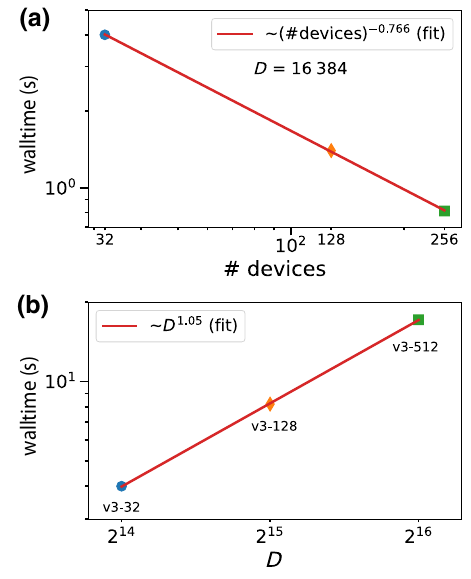
FIG. 5. (a) Strong scaling analysis for a DMRG-style matrix- vector operation for a bond dimension of D = 16384 on an increasingly larger number of TPU cores. Doubling the number of devices we observe a roughly (2 0.766 ≈ 1.7)-fold reduction in runtime. For ideal strong scaling, the slope of the line would be − 1, compared to the measured − 0.766. (b) Weak scaling analysis of the same DMRG-style matrix vector operation as in (a). Between subsequent data points from left to right, the bond dimension is doubled while the number of devices is